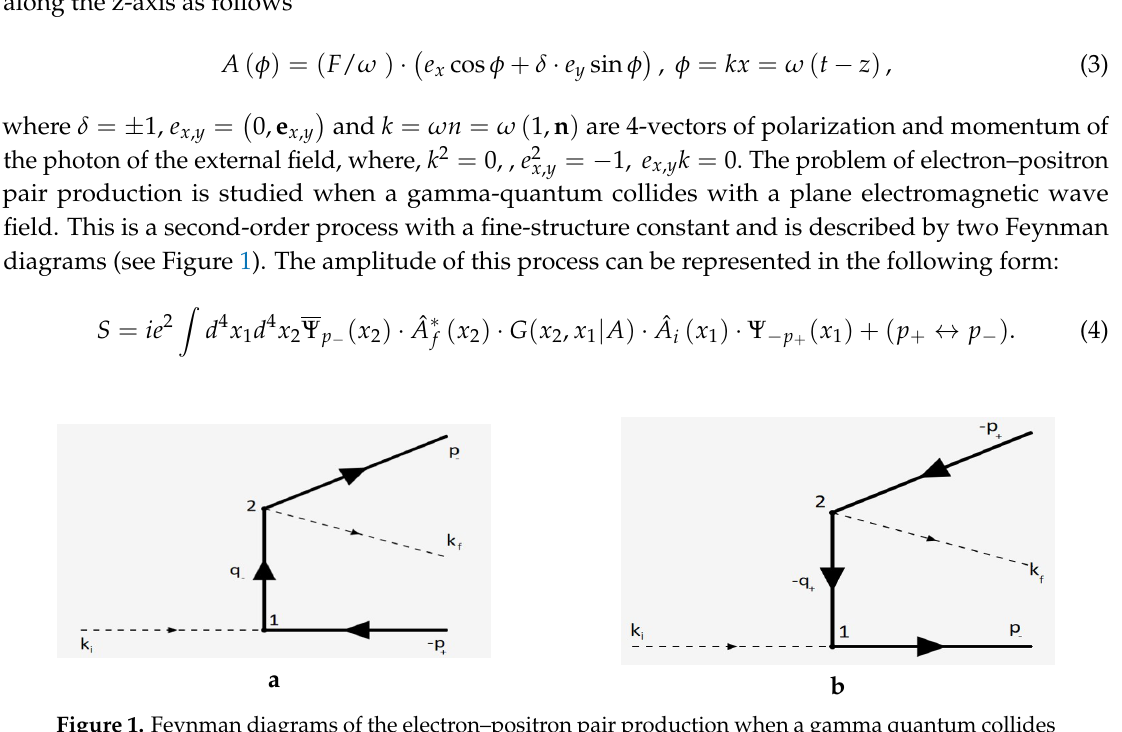
Figure 1. Feynman diagrams of the electron–positron pair production when a gamma quantum collides with an electromagnetic wave. The solid lines correspond to the ( b ) electron and ( a ) positron Volkov’s functions, the inner lines of the electron (positron) Green’s function in the wave field, dashed lines stand for initial and final gamma